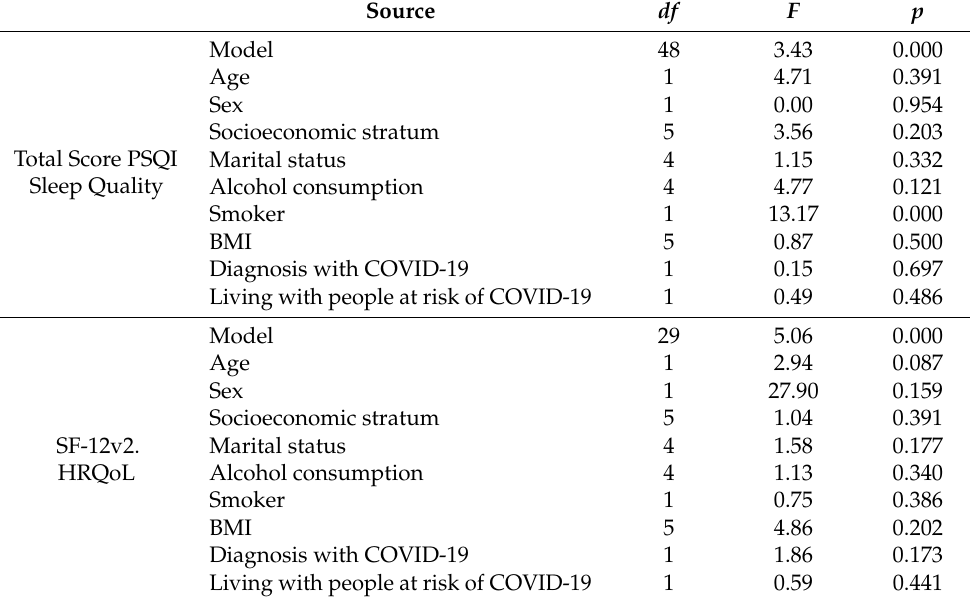
Table 4. Analysis of covariance of the sleep quality and health-related quality of life adjusted for sociodemographic